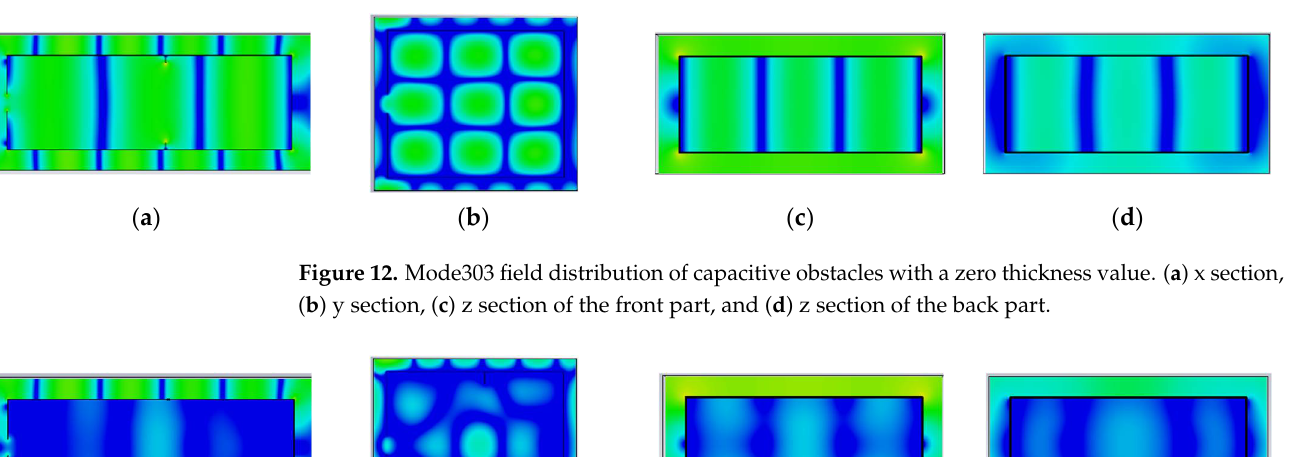
are relatively consistent with the cross-coupling.